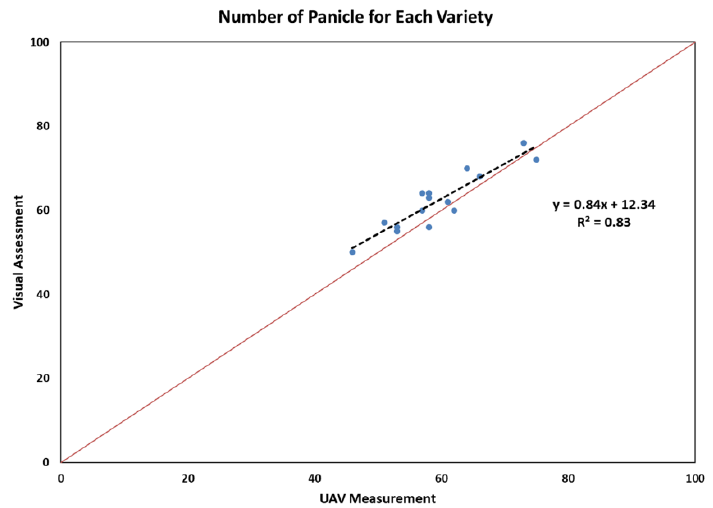
Figure 4. Relationships of panicle numbers by visual assessment and using the proposed method to detect individual sorghum panicles from the UAV image. The red line indicates the 1-to-1 line.